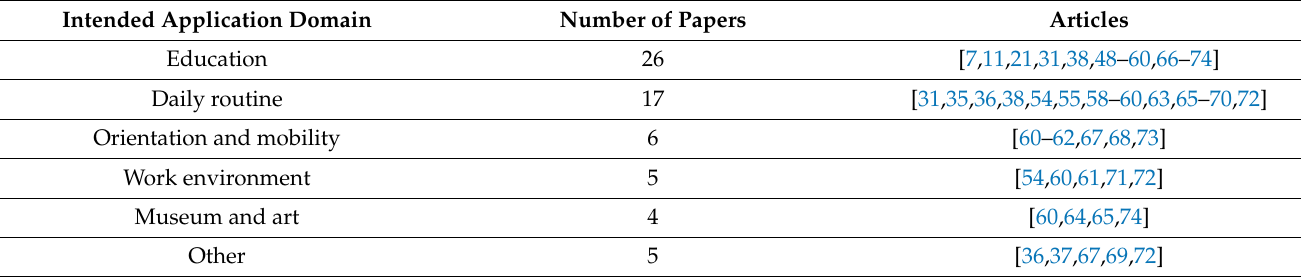
Table 7. Intended application domain of currently available methods, software and hardware. Intended Application Domain Number of